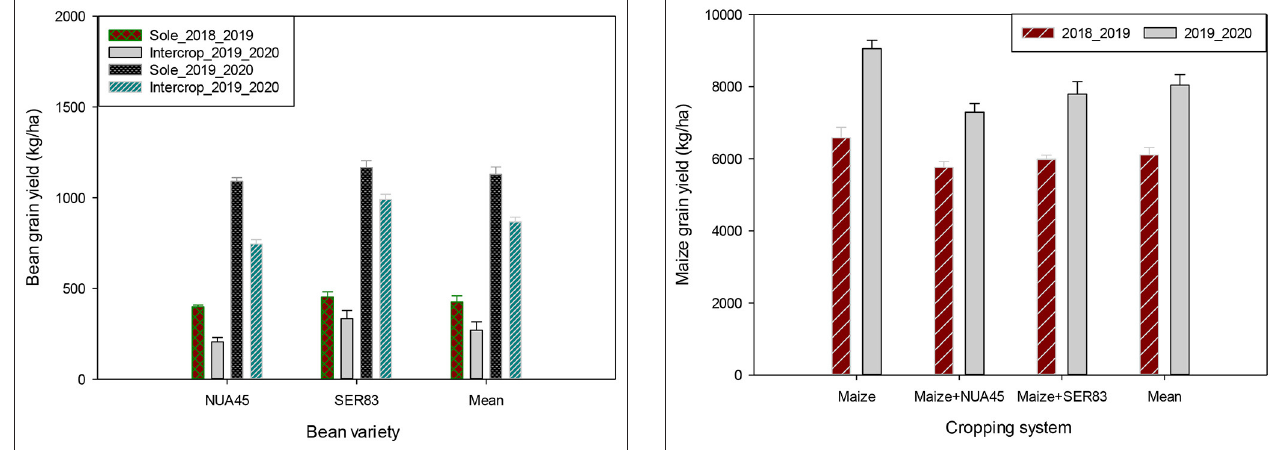
NUA45 (10). The average for NPP across season and site was higher in sole cropping system (14) than intercrop (12). SER83